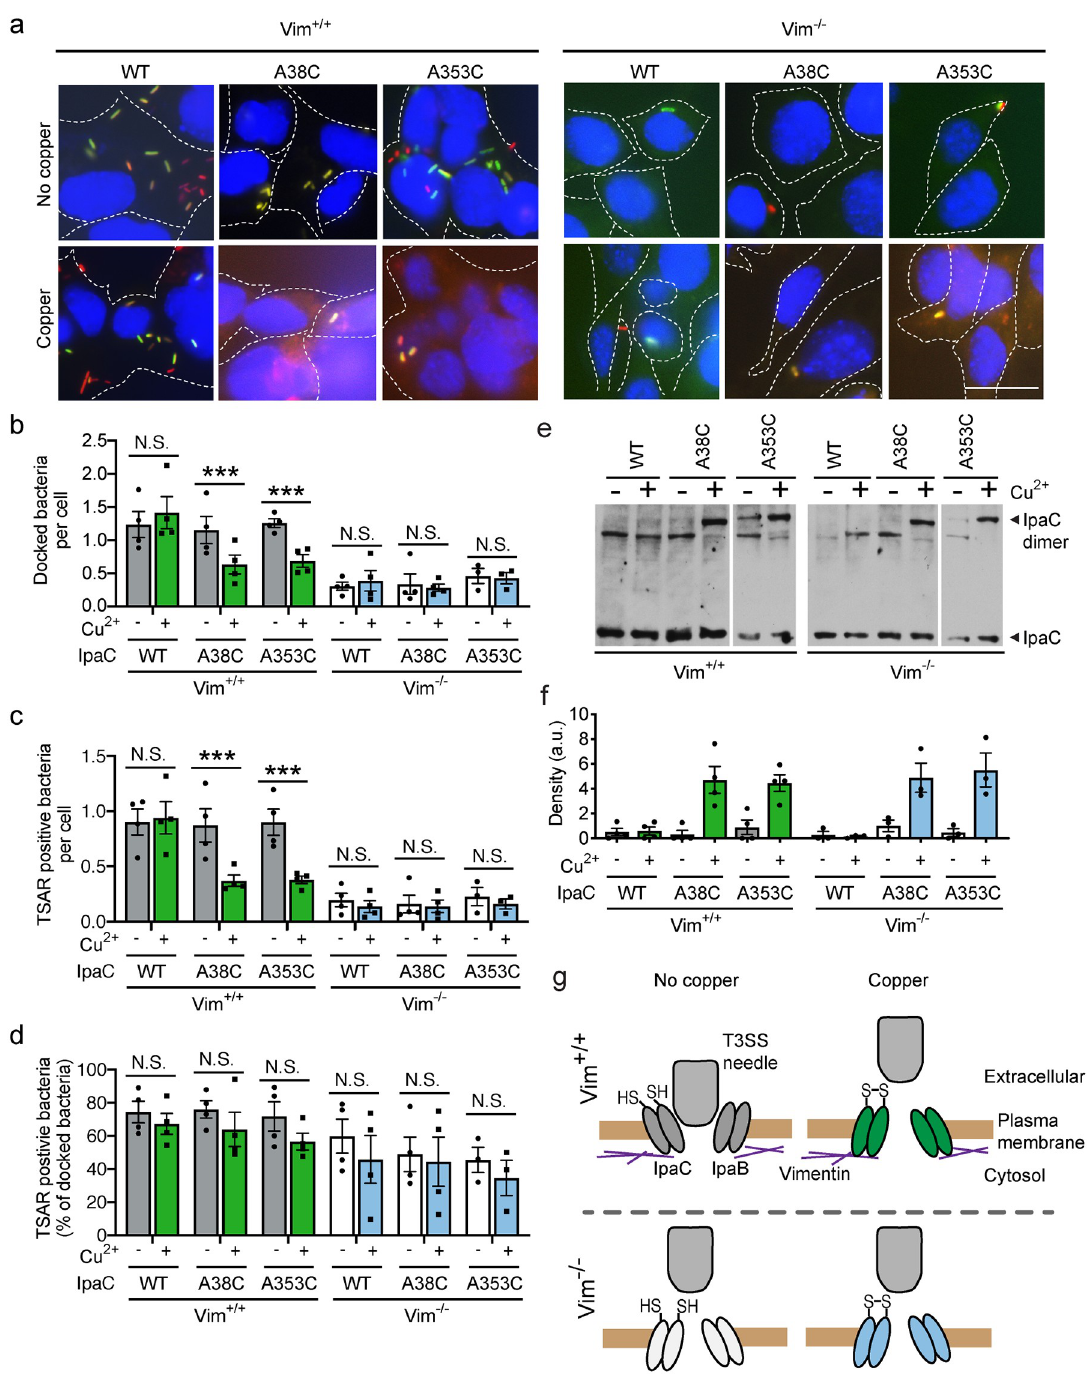
Fig 2. Intermolecular crosslinking of IpaC molecules in the translocon pore at the time of initial bacterial contact with cells inhibits docking. Efficiency of docking and T3SS-mediated secretion upon addition of the oxidant copper during S . flexneri infection of Vim +/+ or Vim -/- MEFs. Copper was added at the time of initial bacterial contact with cells. IpaC or its derivatives were expressed in S . flexneri Δ ipaC containing the TSAR reporter of T3SS secretion [37]. (a) Representative micrographs of S . flexneri -infected cells, imaged at 50 minutes of infection. Blue, DNA; red, mCherry (all bacteria); green, GFP (bacteria actively secreting through T3SS). Scale bar, 20 μ M. (b) Efficiency of docking of bacteria on cells. (c-d) The number of docked bacteria per cell ( c ) and the percentage of docked bacteria that are actively secreting ( d ), as indicated by TSAR reporter, from images in experiments represented in panel a . (e) IpaC dimer formation analyzed at 20 minutes of infection. Non-reducing western blot of IpaC, representative of three independent experiments; all panels are from the same blot. (f) Densitometry analysis of bands corresponding to IpaC dimers in experiments